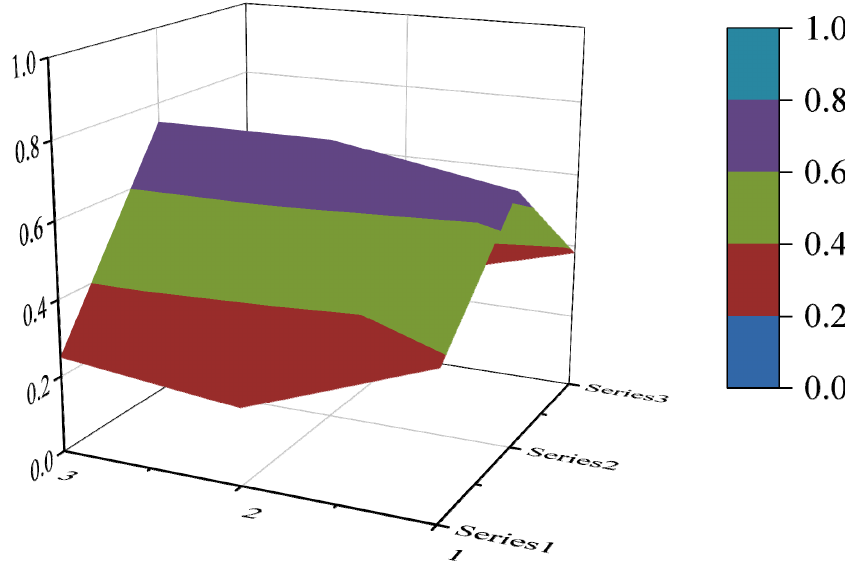
Figure 9. The PMC surface of P8.